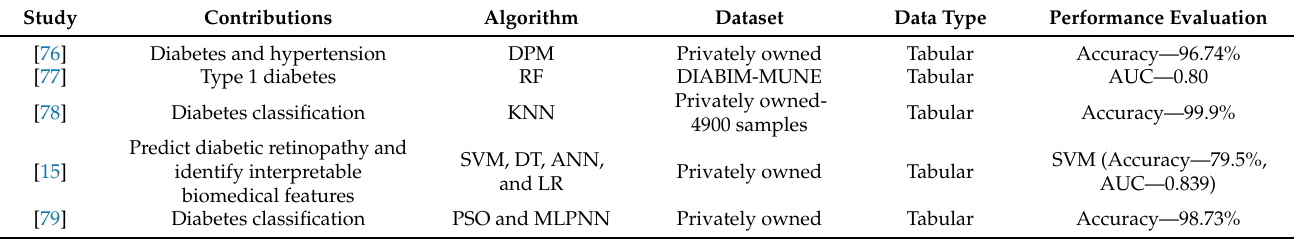
Table 6. Referenced literature that considered machine-learning-based diabetic disease